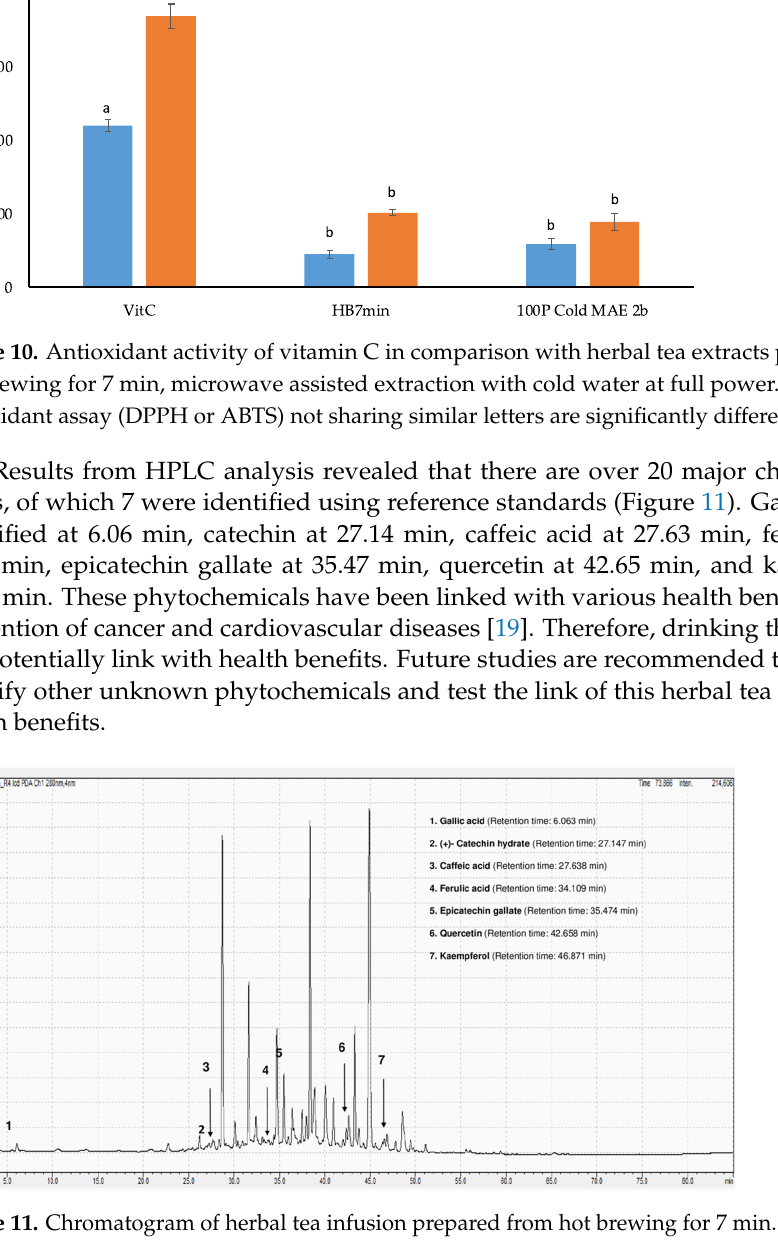
Figure 11. Chromatogram of herbal tea infusion prepared from hot brewing for 7 min. Detection was conducted using a PDA detector at 280 nm.